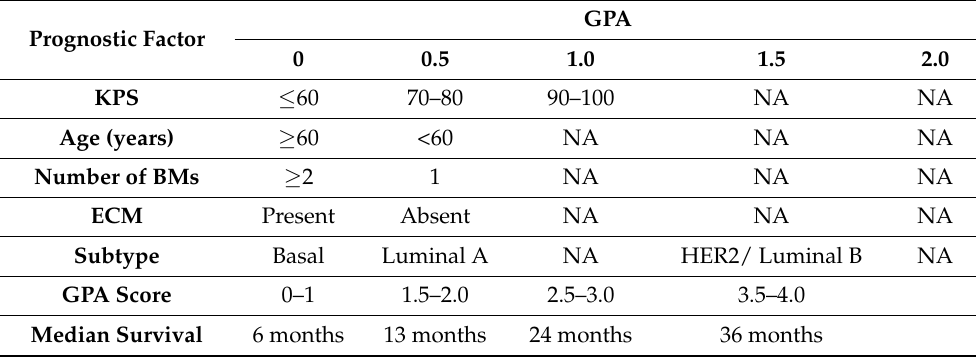
Table 1. Diagnosis-Specific Graded Prognostic Assessment (GPA) modified for breast cancer patients [23,24,26].